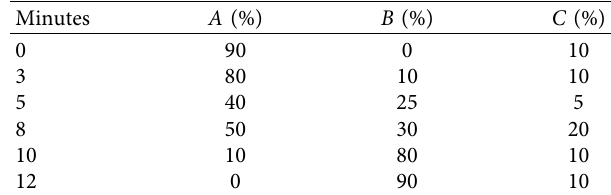
Table 1: Gradient